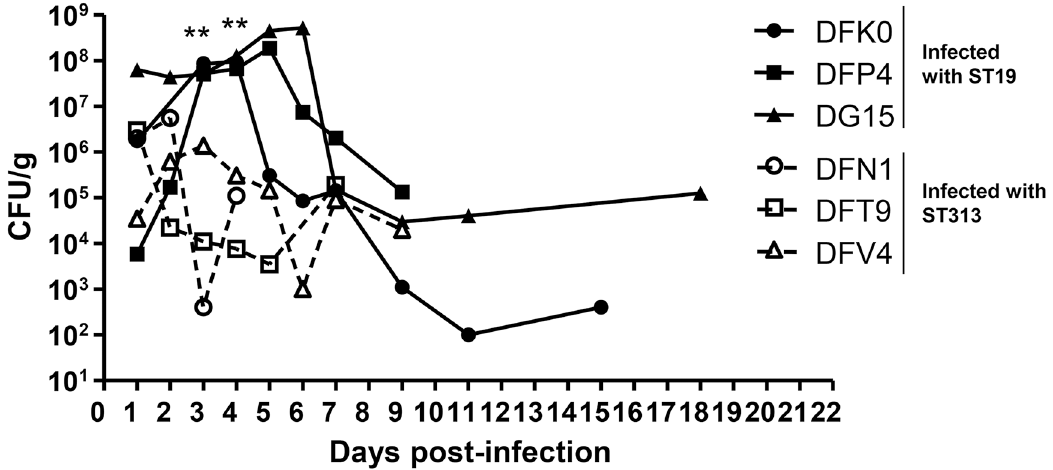
Fig 3. Shedding of Salmonella Typhimurium in the feces of rhesus macaques. Followinginfectionwith Salmonella Typhimurium I77 (ST19) or D65 (ST313), fecal samples were collectedon days 1 to 7, 9, 11, 15, 18 and 21 or 22. Data is represented as CFU per gram of feces. ** representsP < 0.01, Student’s t-test, two-tailed.